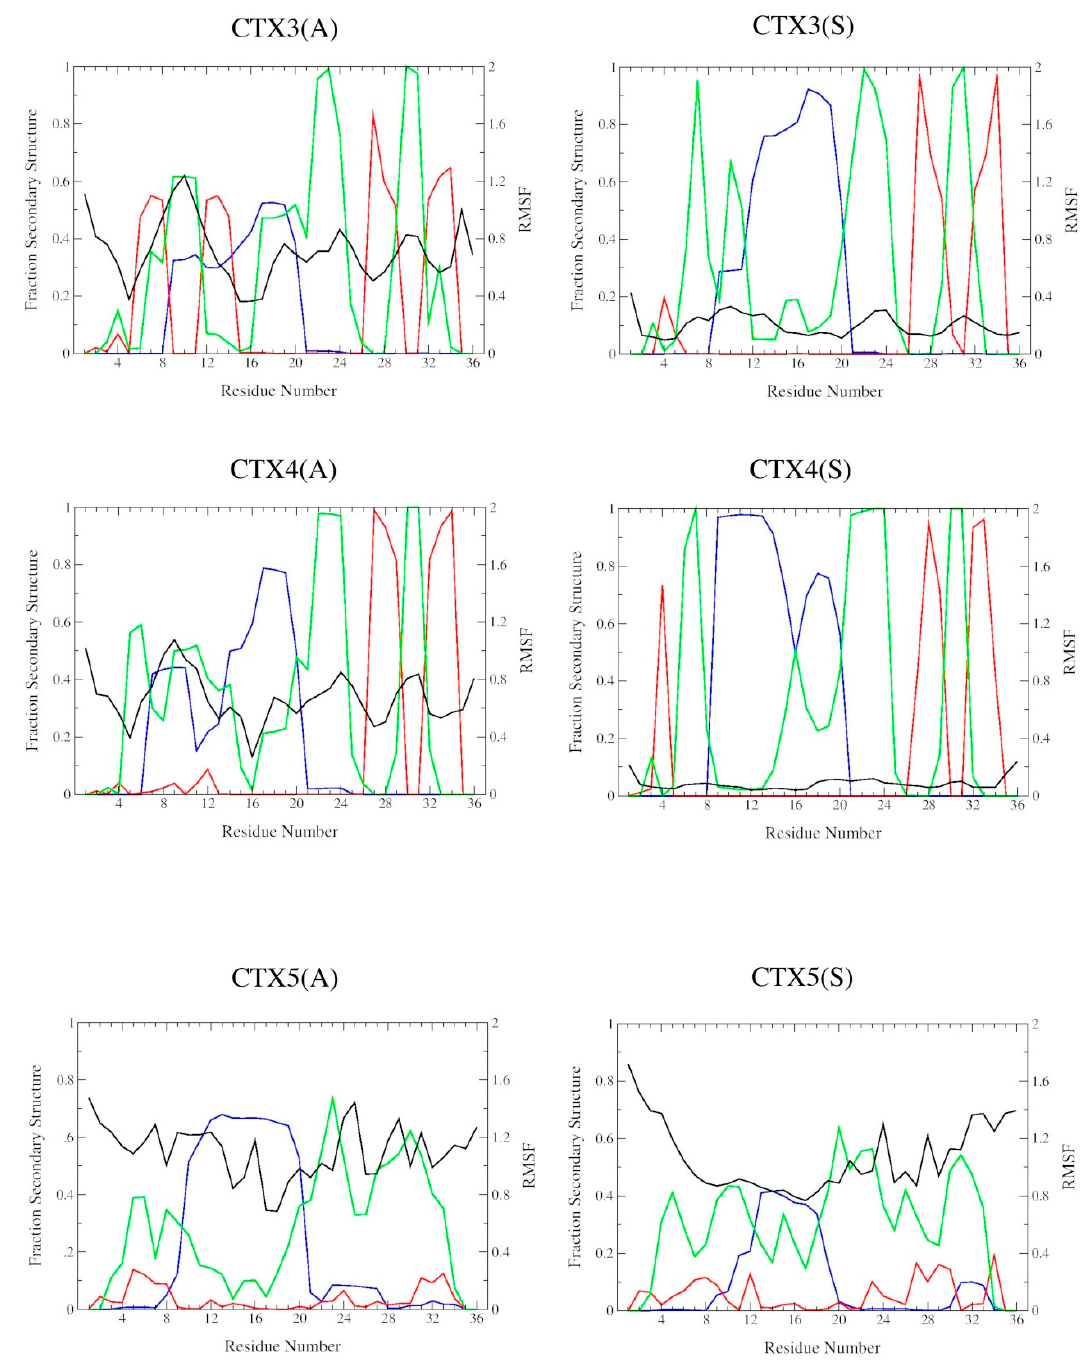
Figure 3. Fractions of sampled DSSP secondary structure ( α -helix, blue; β -sheet, red; and β -turn/bend, green) as a function of residue number and C α -trace root-mean-square fluctuation (RMSF) from the time average conformation of CTX (RMSF, black) for CTX and its Abu- and Ser-substituted analogs.